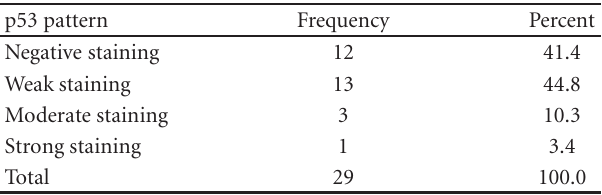
Table 4: p53 expression of nuclear staining in acinar cells surrounding the tumor of pleomorphic